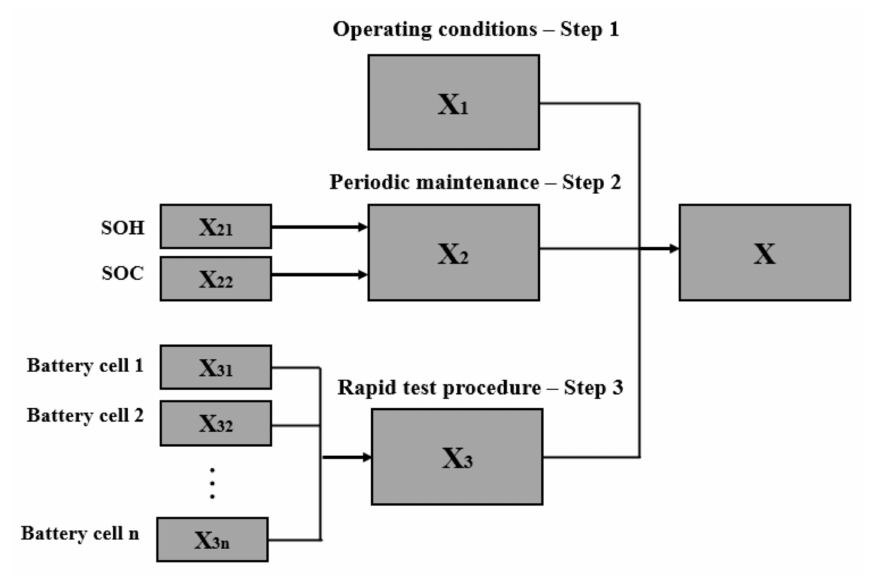
Figure 1. Battery system risk